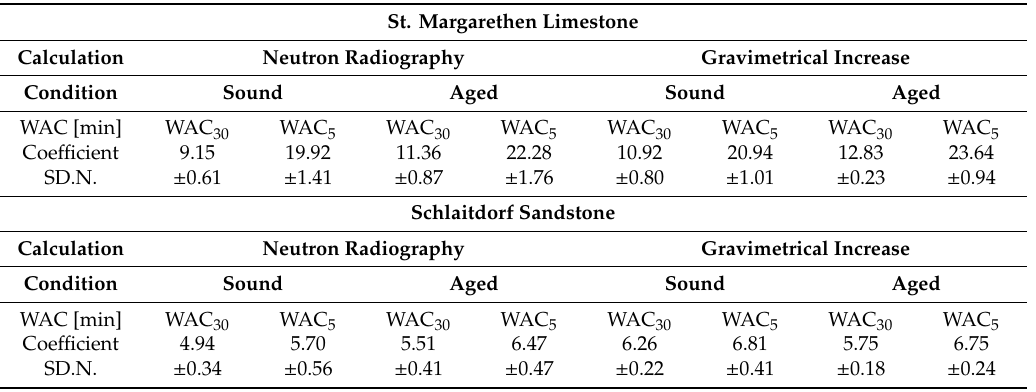
Table 2. Di ff erence between water absorption coe ffi cients calculated after 30 min ( t ) and 5 min ( t ) for sound and aged St. Margarethen Limestone and Schlaitdorf Sandstone, reported as [kg / (m 2 t 0.5